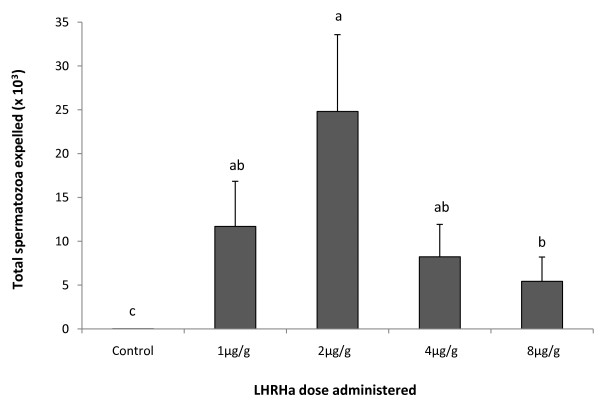
Total number of spermatozoa (× 103) released by males administered LHRHa (n = 10) over a 12 h sampling period. Data shown are untransformed mean ± SEM. Letters displayed are the result of a Tukey Kramer HSD post-hoc test of Log10 (x +1) transformed data. Treatments that share a letter are not significantly different from each other.